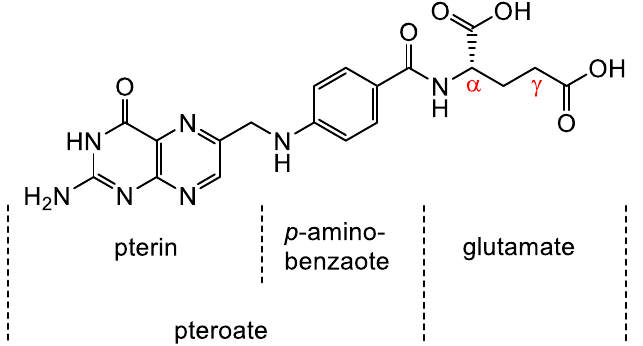
Figure 1. Chemical structure of folic acid (FA) consisting of glutamic acid entity and a pteroyl moiety that entails pterin and p-aminobenzoate groups. Derivatization of FA occurs via either the α - or γ -carboxyl group located in the glutamate moiety.